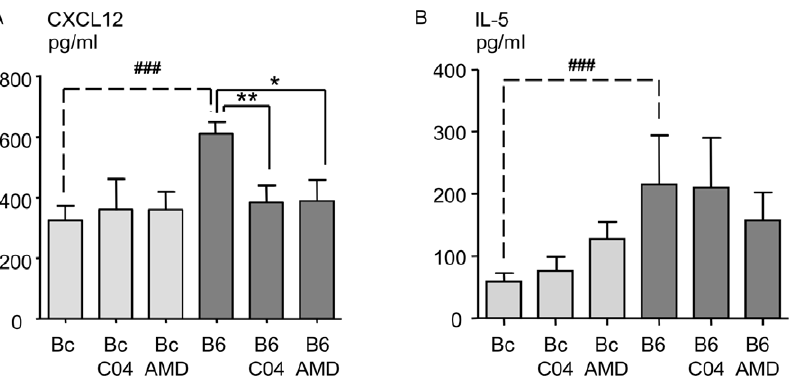
Figure 4. Pleural levels of CXCL12 and IL-5 after disruption of the CXCL12/CXCR4 axis. CXCL12 (A) and IL-5 (B) expression levels measured by ELISA in pleural fluid of BALB/c mice and C57BL/6 mice 30 days post-inoculation and upon blockade either by chalcone (C04) or by AMD3100 (AMD) (days 10 and 20 p.i.). Results are presented after subtraction of the baseline production as mean 6 SEM of 3 pooled independent experiments each carried out with 6 mice per group. The differences between strains and treatments were analysed by a two-way analysis of variance. Strain and treatment effects were significant for the pleural CXCL12 levels, and only the strain effect was significant for the pleural IL-5 level. Further comparisons were assessed by Bonferroni’s multiple comparison test. ‘‘*’’ represents significant differences between treatments within one strain of mice (*p , 0.05, **p , 0.01); # shows significant differences between strains for one given treatment ( ### p , 0.001).